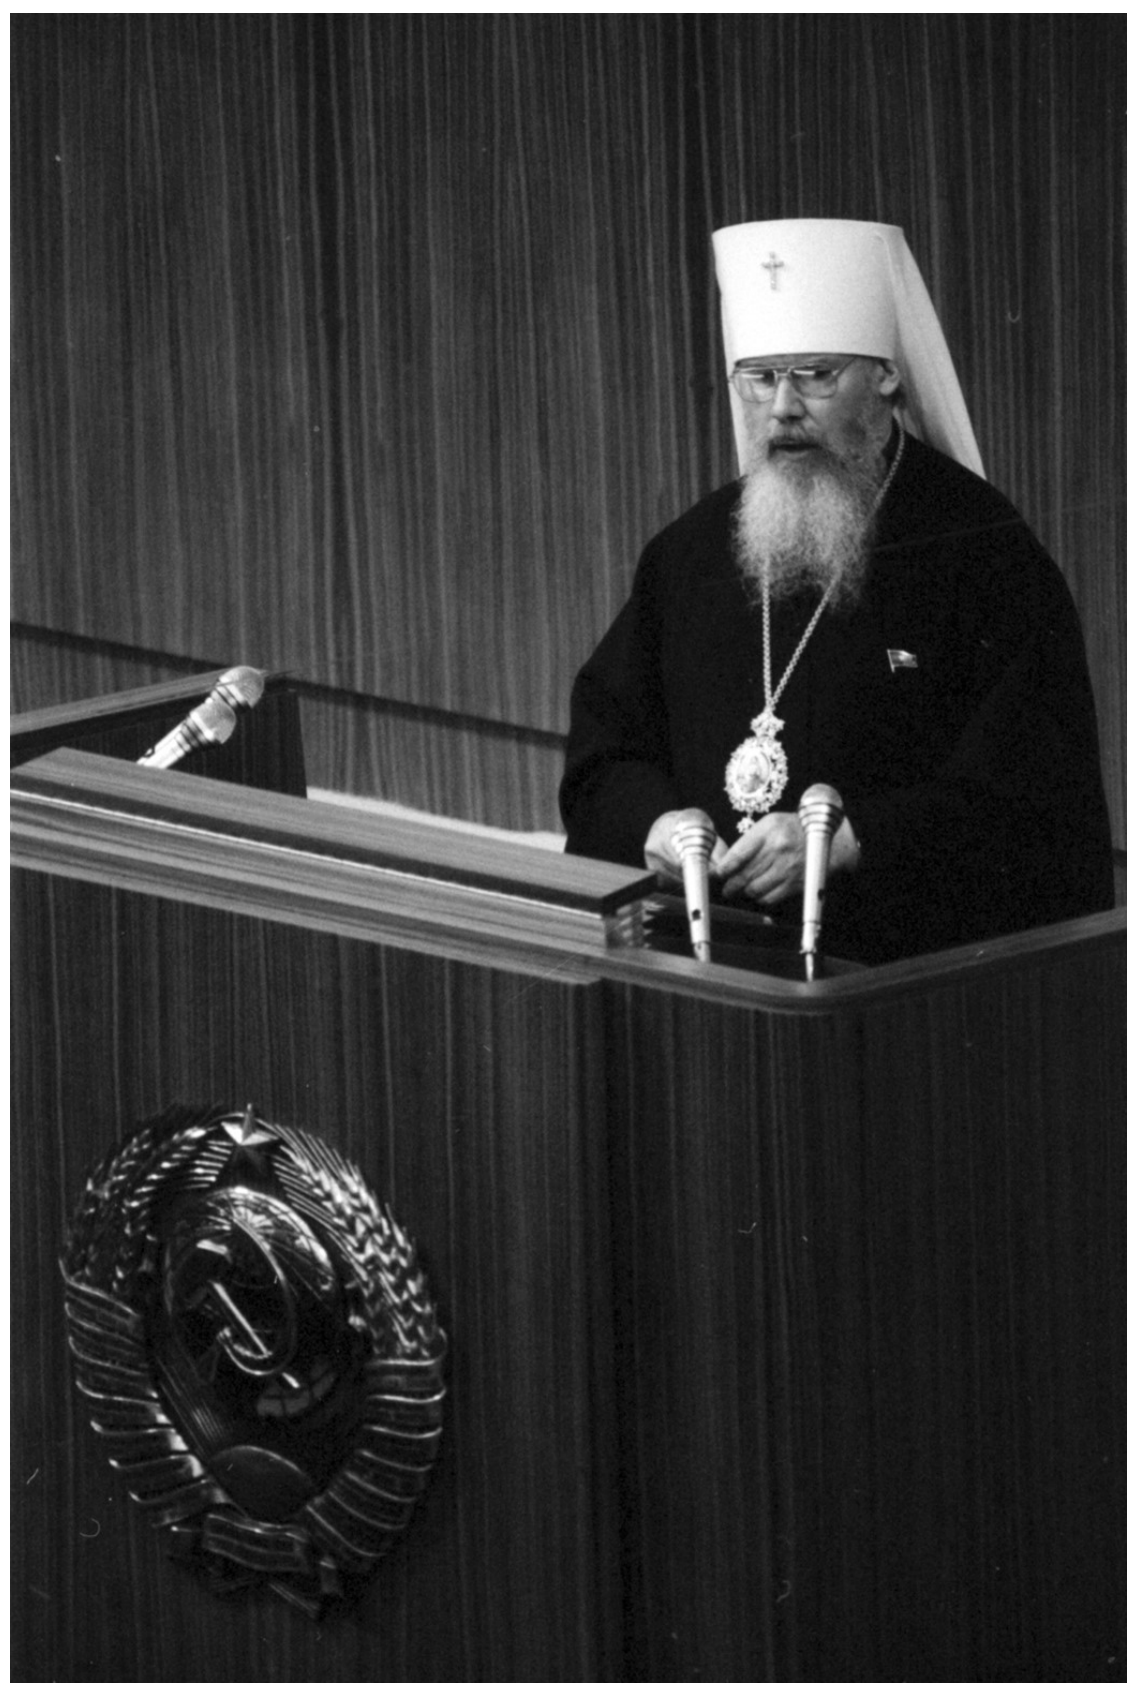
Figure 1 Deputy from the Soviet Foundation for Charity and Health, Metropolitan of Leningrad and Novgorod Alexy (Ridiger) during a speech at the First Congress of People’s Deputies of the USSR, Moscow, May 31, 1989. Photo by V. Zav’ialov. From the collection of the Russian State Film and Photo Archive (RGAKFD), Krasnogorsk, Item